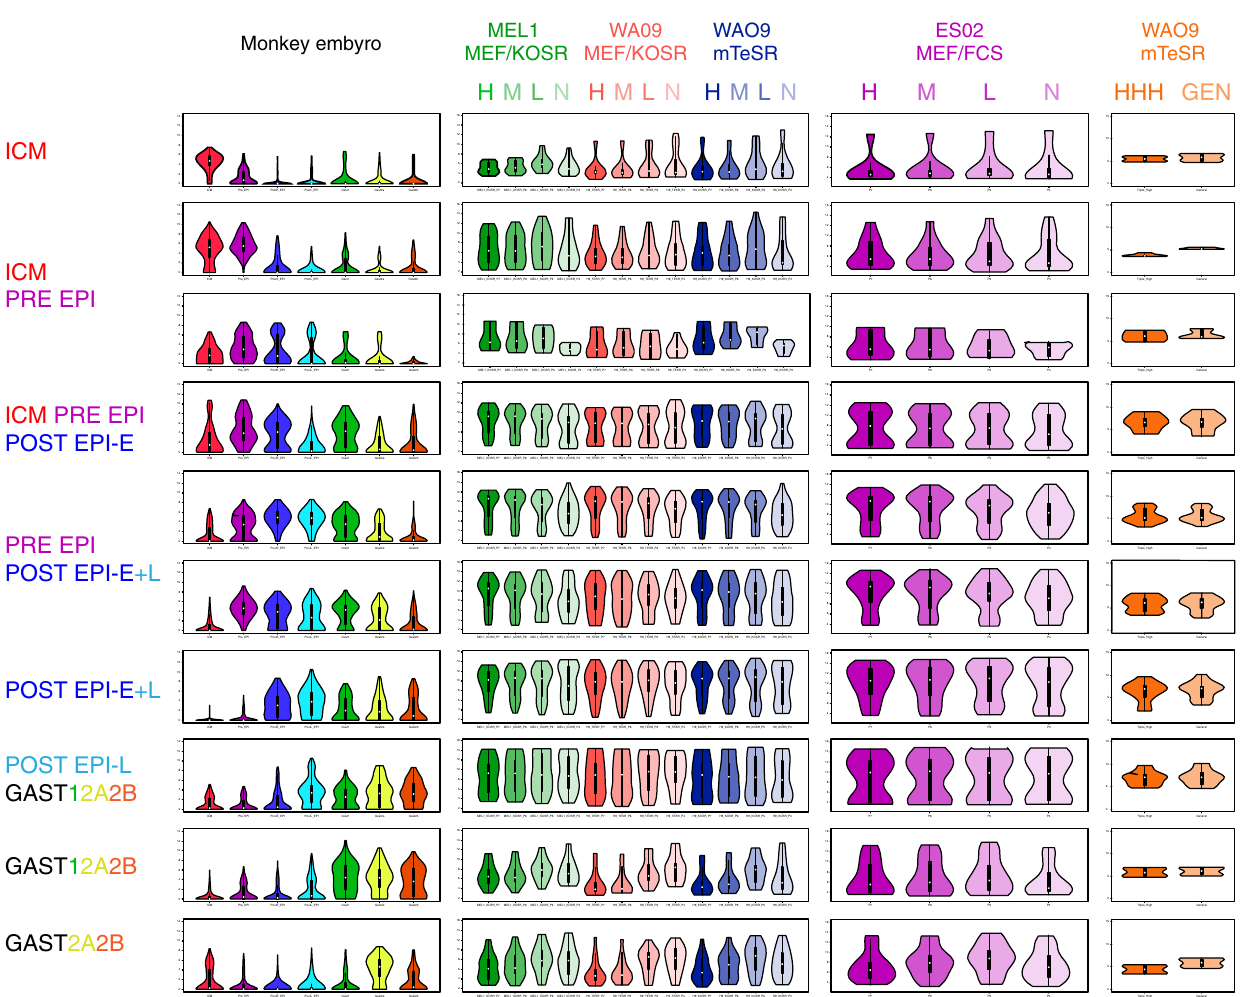
Fig. 9 String section plot comparison of expression of embryonic stage-speci fi c genes by scRNA-seq in cynomolgus embryo 30 with expression in subpopulations of hPSC. The violin plots in the left hand column show expression from single-cell RNA-seq data in ref. 30 , with classi fi cation of cells as described therein; embryonic stages in which particular gene sets (Supplementary Table 4, each row in the fi gure displays violin plots for one gene set) are expressed are listed to the left of the plots. The second column shows microarray data from ref. 27 for the same sets of genes in GCTM-2 high CD9 high (H), GCTM-2 mid CD9 mid (M), GCTM-2 low CD9 low (L), and GCTM-2 neg CD9 neg (N) subpopulations of MEL1 cells grown in the presence of medium containing Knockout Serum Replacer on mouse embryo fi broblast feeder cell layers (MEF/KSOR), or WA09 cells grown in MEF/KSOR or mTeSR de fi ned medium. The third column shows microarray data from ref. 16 for the same sets of genes on GCTM-2 high CD9 high (H), GCTM-2 mid CD9 mid (M), GCTM-2 low CD9 low (L), and GCTM-2 neg CD9 neg (N) subpopulations of ES02 cells grown in serum-containing medium on mouse embryo fi broblast feeder cell layers (MEF/FCS). The last column shows RNA-seq bulk data on the same sets of genes from the current study for GCTM-2 high CD9 high EPCAM high (HHH) and unsorted (GEN) cells. Colors of violins correspond to embryonic stages or cell subpopulations identi fi ed in labels at left or top of fi gure (last three columns),